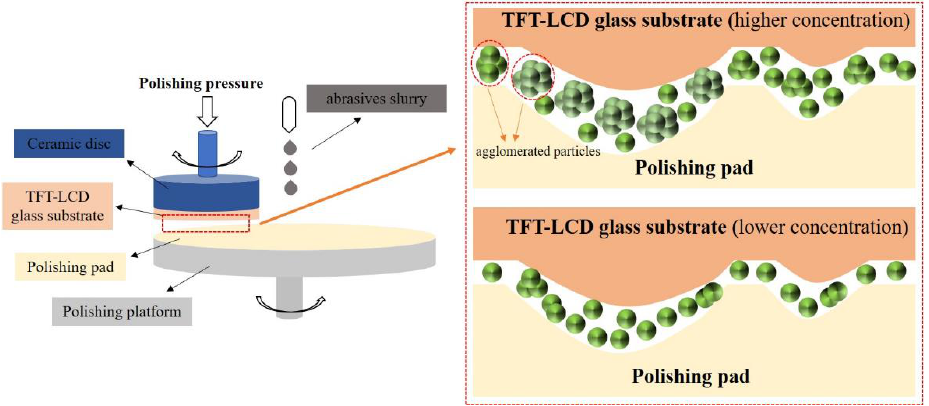
Figure 8. Schematic diagrams of the CMP process by using ceria-based abrasives in different con- centrations.